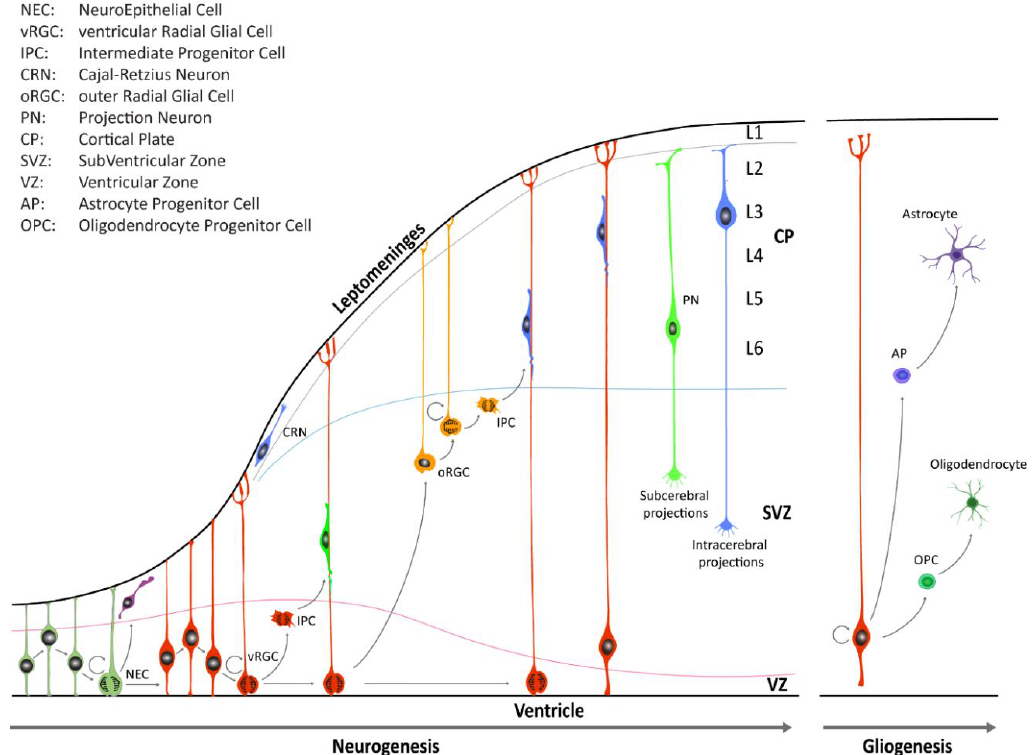
Figure 1. Schematic illustration of neocortical development. Neuroepithelial cells (NECs) undergo symmetric cell division to expand the initial pool and later transition into ventricular radial glia cells (vRGCs). vRGCs begin asymmetric cell division to generate another vRGC and a nascent projection neuron. Neurons then migrates radially from the ventricular zone (VZ) along the RGC basal processes into the cortical plate (CP). Early-born projection neurons (PNs) settle in the deep layers (Layers 5 and 6), and later-born neurons in upper layers. Additionally, some populations of RGC daughter cells convert themselves into intermediate progenitor cells (IPCs) or outer radial glial cells (oRGCs) in the subventricular zone (SVZ). After the neurogenic stages, gliogenesis occurs, generating astrocytes and oligodendrocytes.